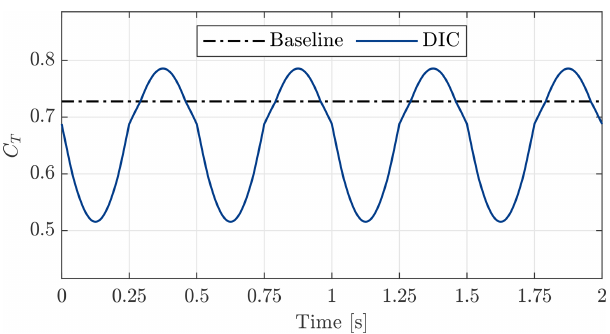
Figure 3. Thrust coefficient reference for baseline control and pe- riodic dynamic induction with a frequency of 2Hz ( St = 0 .